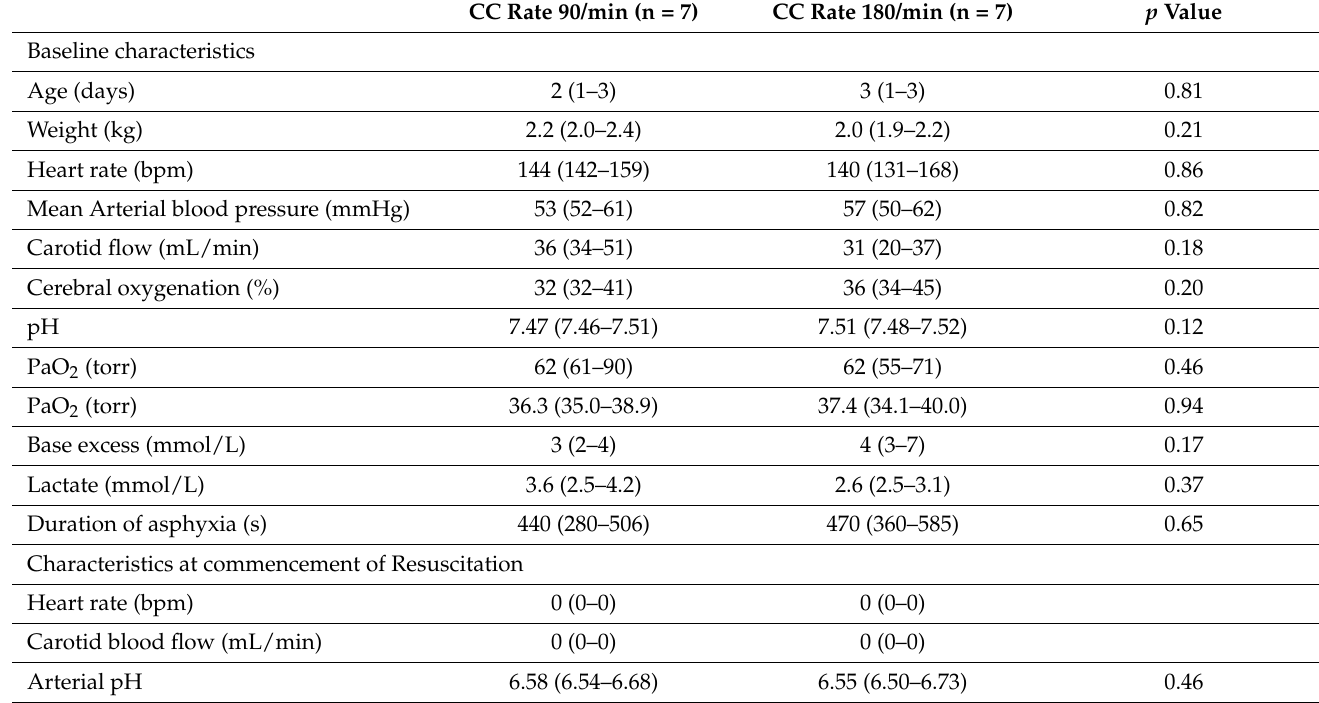
Table 1. Characteristics of Newborn Piglets at Baseline and at Commencement of Cardiopul- monary